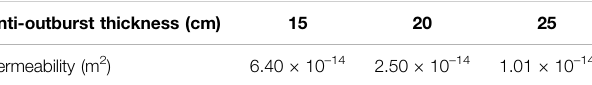
TABLE 2 | Permeability under different anti-outburst thicknesses.